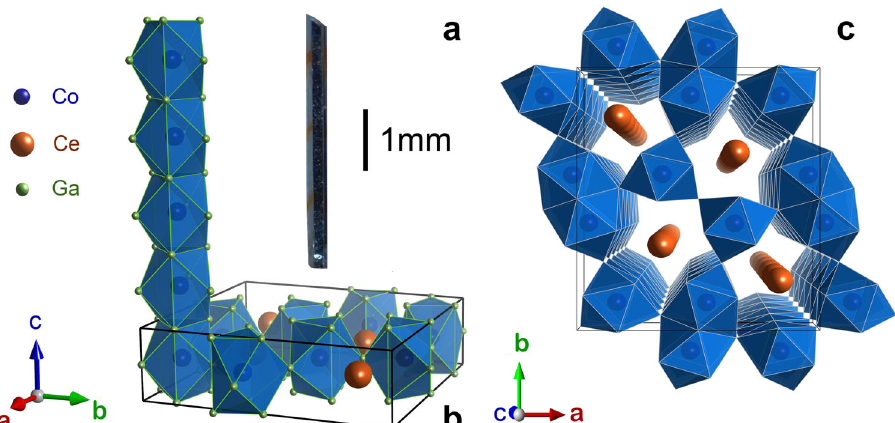
Fig. 1 Crystalline structure of CeCo 2 Ga 8 . a Picture of a single crystal of CeCo 2 Ga 8 of about 4 mm in length along the c -axis. b Side view of the YbCo 2 Al 8 -type orthorhombic structure with face-shared CoGa 9 cages along the c -axis. c Stereoscopic view of the crystal structure showing the quasi-1D chains of Ce atoms along the c -axis. Each unit cell contains four Ce atoms and the interchain Ce – Ce distances are 6.5 and 7.5 Å, respectively